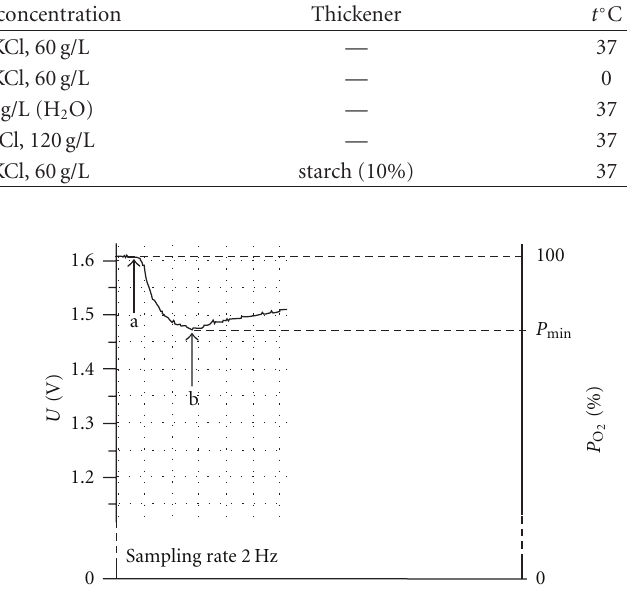
Figure 2: Typical registration curve of false oxygen consumption. (a) the time of additive introduction and (b) the minimal value of oxygen partial pressure ( P min ). Recorded by ADC L-154 (L- Card, Russia), application PowerGraph (D. Izmailov, Russia). Curve